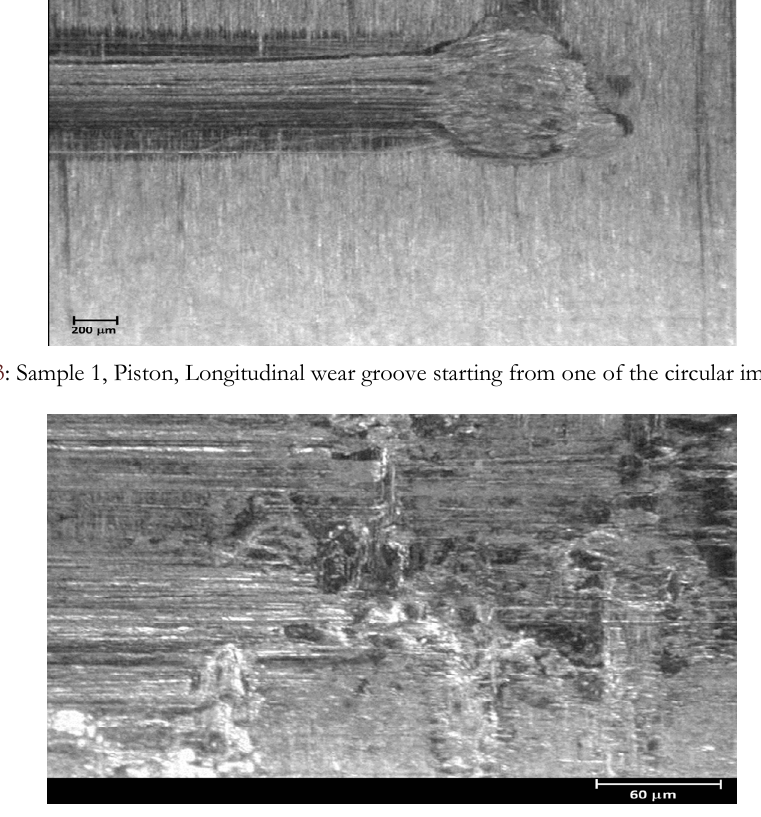
Figure 4: Sample 1, Piston, Scored area in the central part of the component.